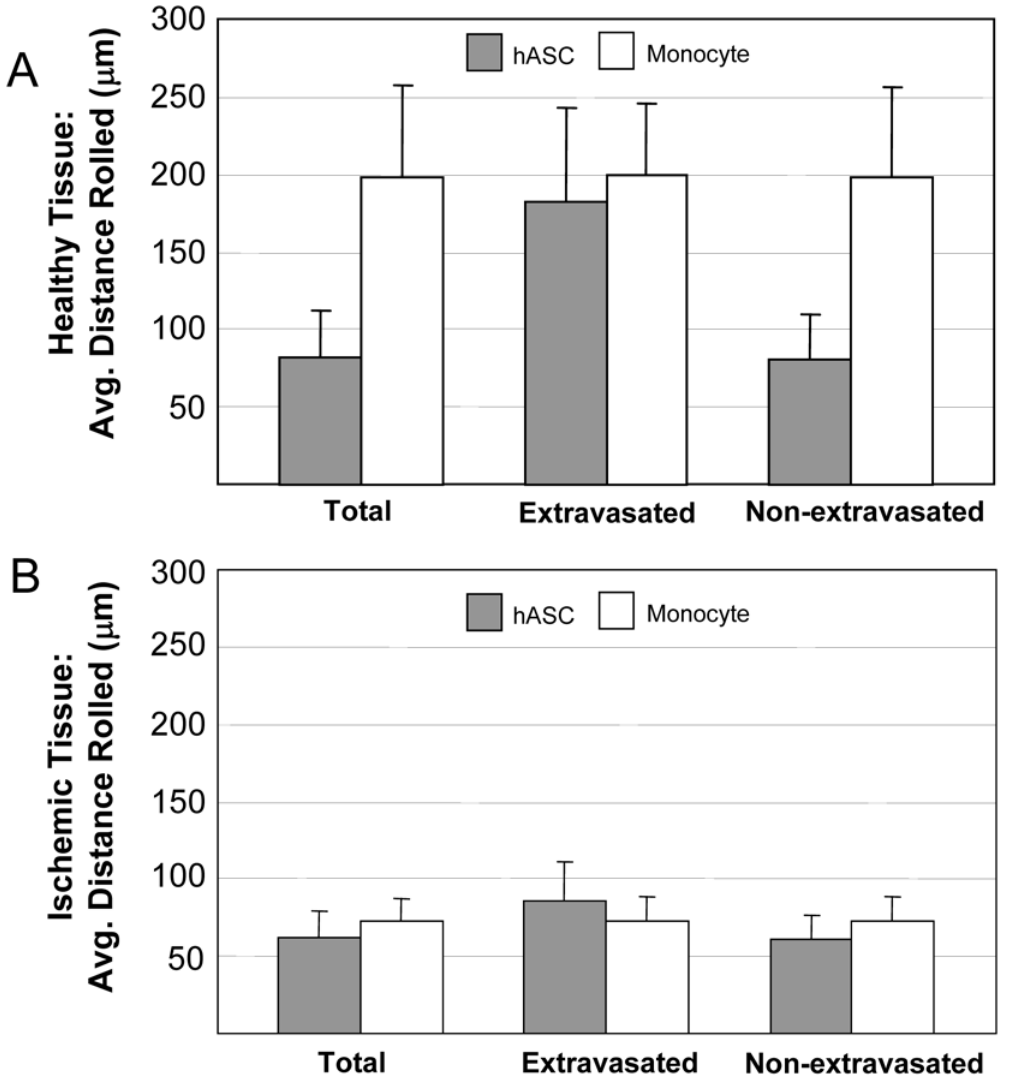
Figure 6. The ABM reproduced appropriate monocyte and hASC rolling distances in simulations of trafficking in both healthy and ischemic tissues. Data presented as the average across all the cells in the phenotype, as well as according to whether cells eventually extravasated. (A) In simulations of healthy microvascular networks, monocytes consistently rolled 200 m m on average. Despite similar rules governing their behavior, hASCs rolling distances varied depending on whether that cell eventually extravasated. (B) In simulations of ischemic microvascular networks, both monocytes and hASC rolling distances were less than levels seen in healthy networks.